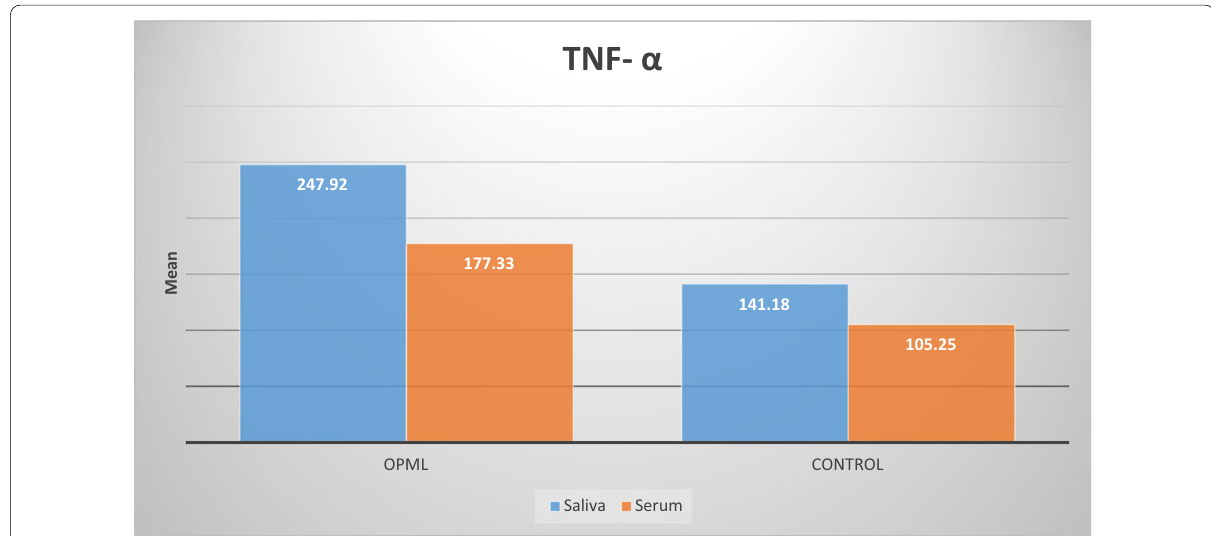
Fig. 10 Bar chart showing mean and standard deviation of TNF in saliva and serum regarding control and OPML groups